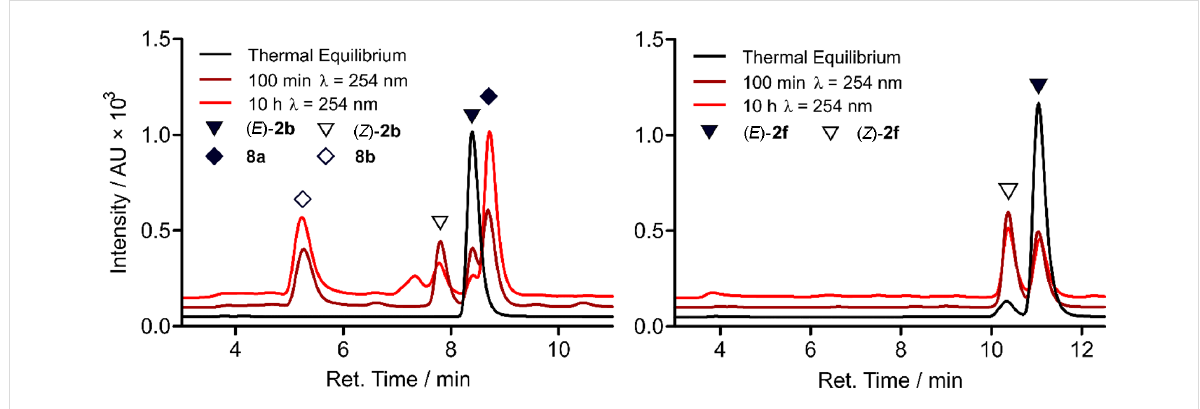
Figure 3: (Left) LC chromatogram of the LC–HRMS analysis of 2b after varying durations of irradiation with 254 nm. Identity of 8a was assigned by the reference compound synthesized and allowed differentiation of the two fractions containing photocyclized compounds, as indicated by mass spec- tra. (Right) LC chromatogram of the LC–HRMS analysis of 2f after varying durations of irradiation with 254 nm.